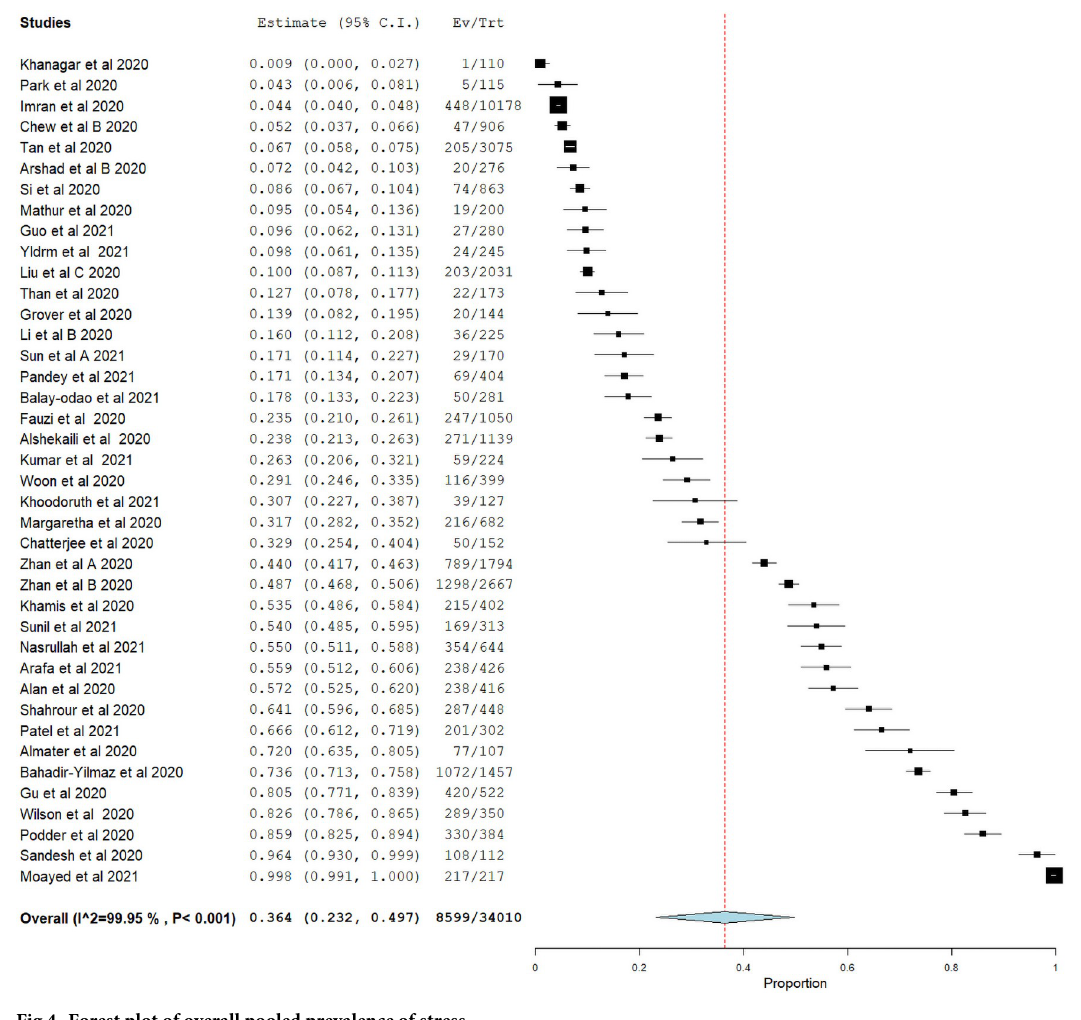
Fig 4. Forest plot of overall pooled prevalence of stress.